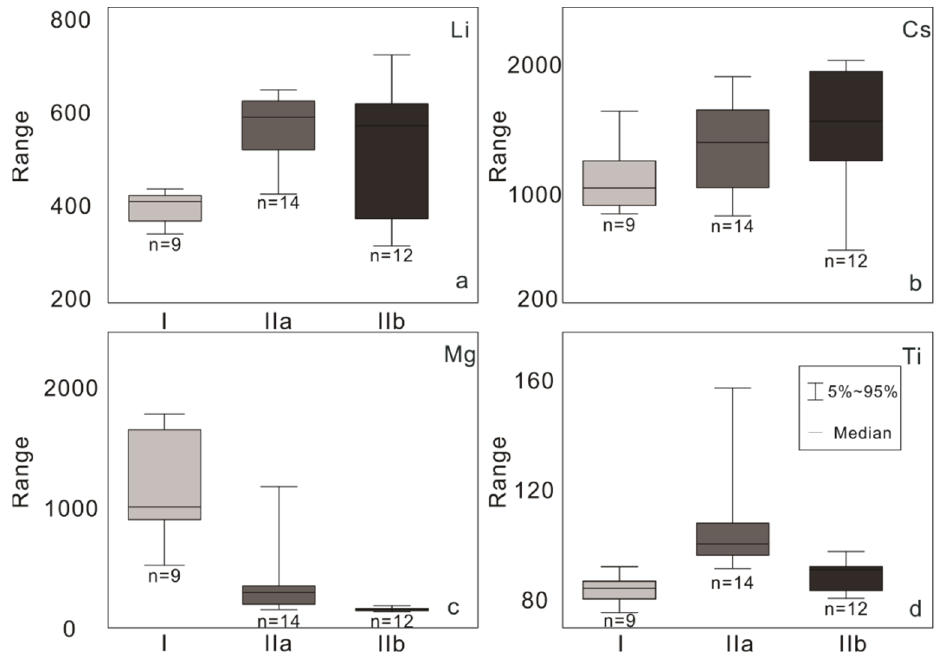
Figure 11. Box plots illustrating variations in Li ( a ), Cs ( b ), Mg ( c ), and Ti ( d ) concentrations of beryl (I, IIa, and IIb) from the Dakalasu No.1